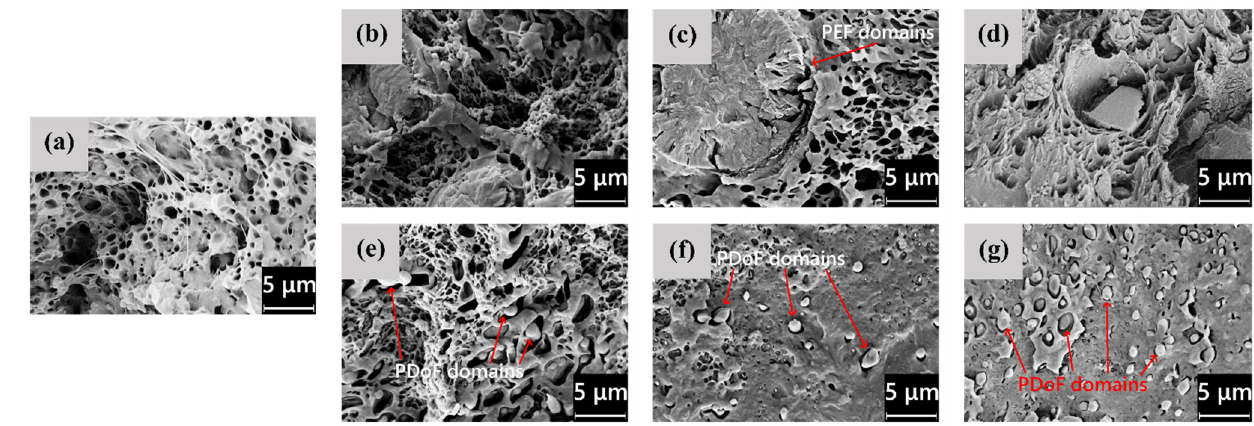
Figure 3. FESEM micrographs of the cross − section of as − spun fibers: ( a ) PLA, ( b ) PEF − 2.5% − as, ( c ) PEF − 5% − as, ( d ) PEF − 10% − as, ( e ) PDoF − 2.5% − as, ( f ) PDoF − 5% − as, ( g ) PDoF − 10% − as.